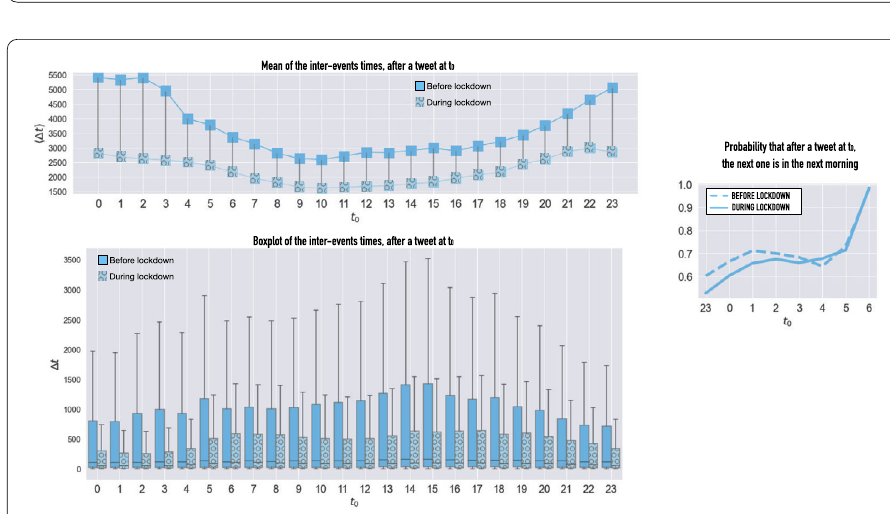
Figure 4 Interevents: Left plots: Average inter-event distance for an event starting at time t 0 and boxplot of the interevents starting at t 0 . Right plot: Probability that a tweet following a tweet at t 0 is posted on the following morning (dashed = before lockdown, solid = during